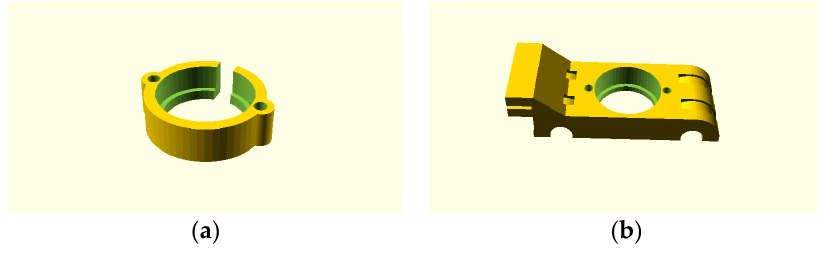
Figure 2. Printed four-point probe holder showing mounted four-point probe head. Figure 3. OpenSCAD images showing: ( a ) Probe holder top part; ( b ) Carriage part x-axis mount.